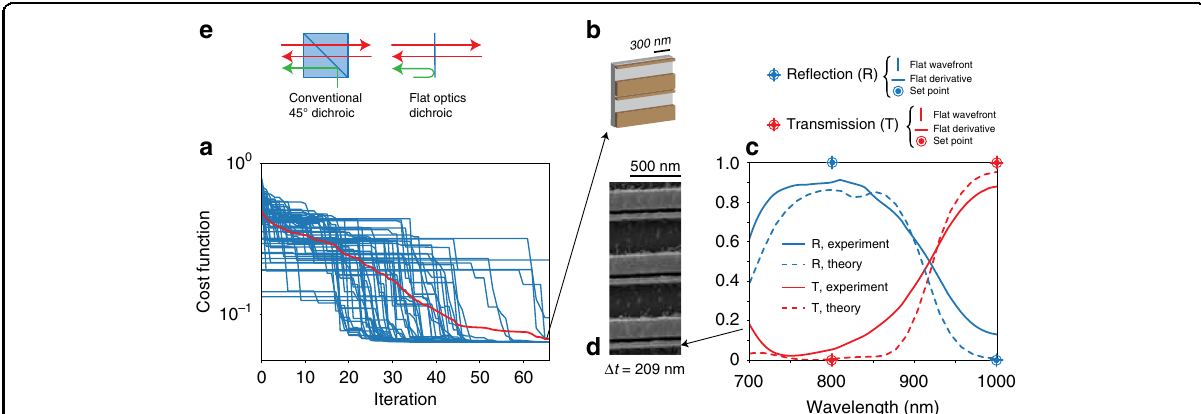
Fig. 5 Flat-optics dichroic mirror. a Cost function of the target design for increasing iterations of ALFRED (blue: particles, red: mean value), and b sample design found. The dichroic component is designed based on 4 target points ( c , blue/red markers), each characterized by a fl at derivative and a fl at wavefront. c Comparison of FDTD theoretical (dashed line) and experimental (solid line) results. d SEM image of a fabricated sample. e Conventional dichroic geometry, requiring 45° impinging light, versus the fl at-optics structure working at normal